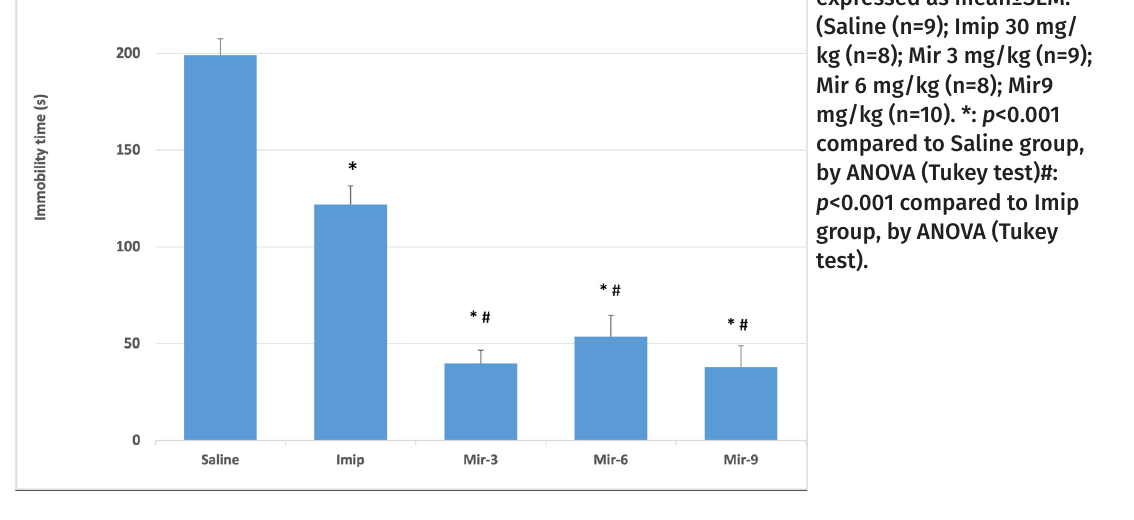
Figure 1. Immobility time (in seconds) in the forced swim test. Data were expressed as mean±SEM.